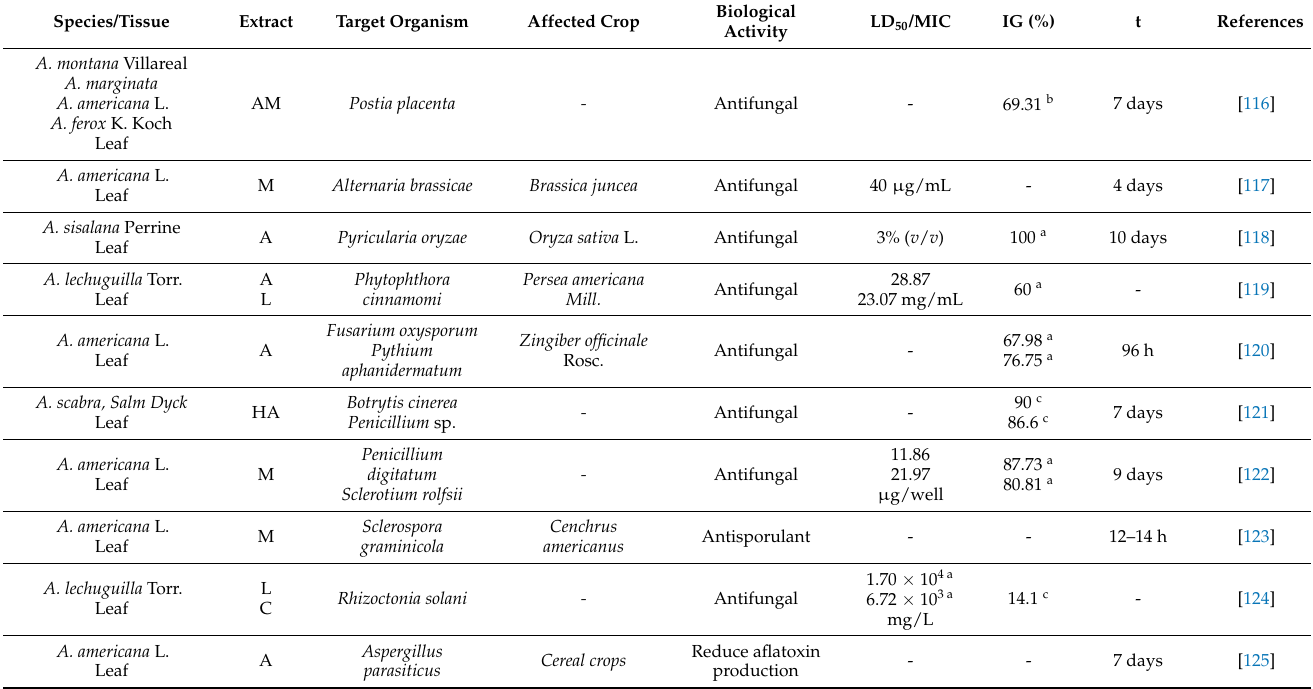
Table 4. Antifungal potential of agave